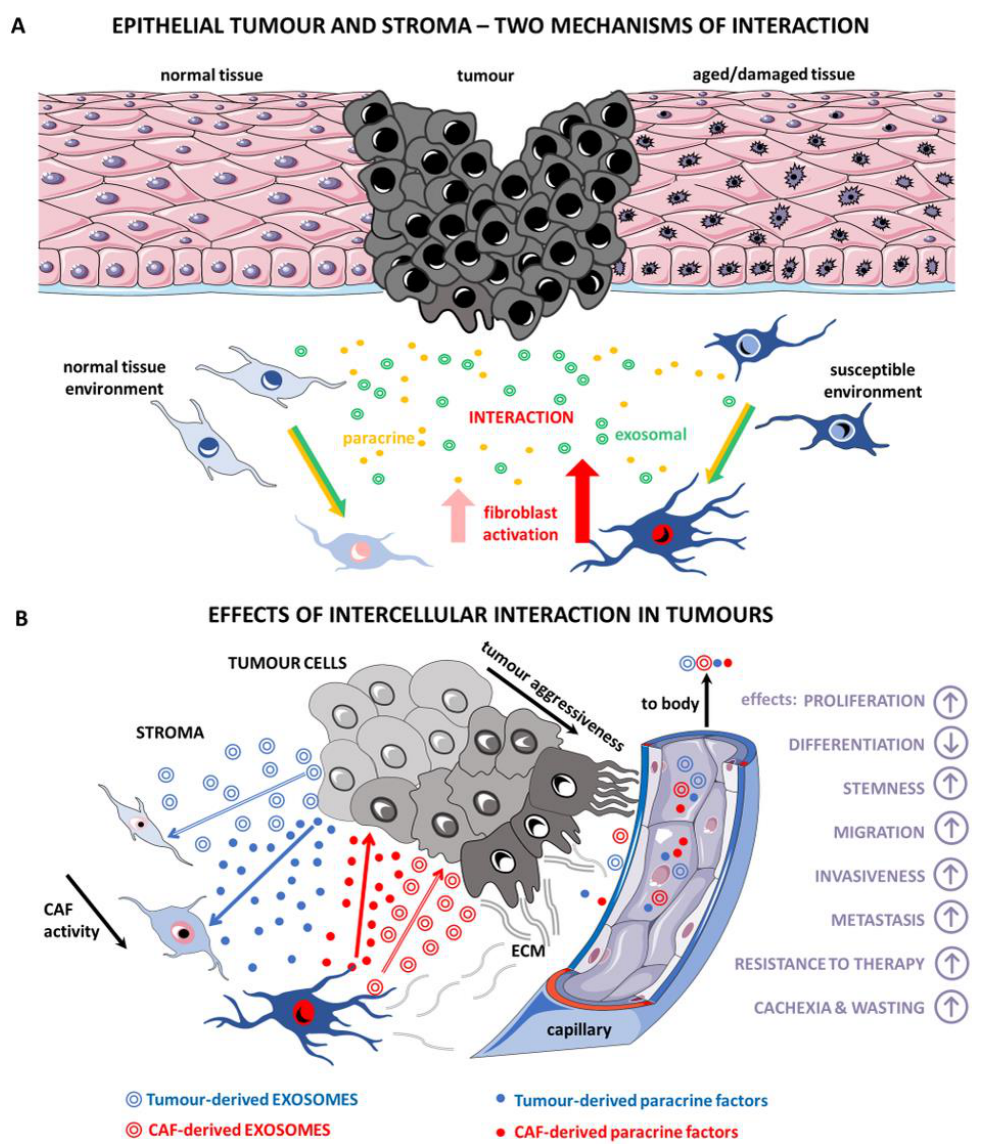
Figure 6. Cancer cells interact with stromal CAFs via the paracrine secretion of bioactive substances, such as cytokines/growth factors, and also release exosomes. This leads to the formation of the permissive microenvironment necessary for tumour progression. The response of normal fibroblasts and aged/damaged fibroblasts to this stimulation is similar, but not identical ( A ). Tumour cells and CAFs use both modes of interaction (exosomal and paracrine) mutually in communication across the landscape of the tumour. These stimuli influence the biological properties of cancer cells, including the formation of metastases, and even exhibit systemic effects, such as wasting and cachexia ( B ).